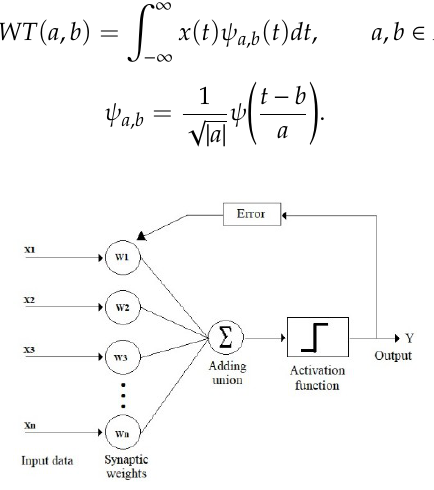
Figure 1. Basic scheme of the perceptron.